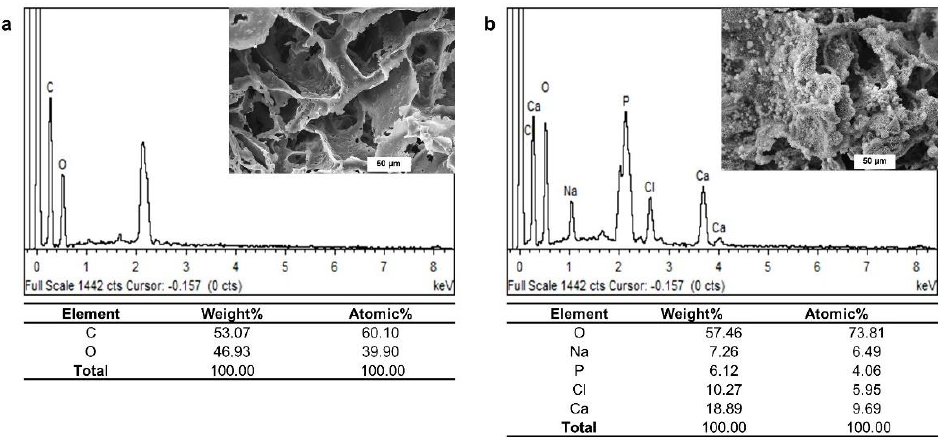
Figure 6. The energy-dispersive X-ray (EDS) spectra of the pristine PLA/PBAT scaffold ( a ) and the PLA/PBAT scaffold with PDA-assisted biomineralization ( b ).